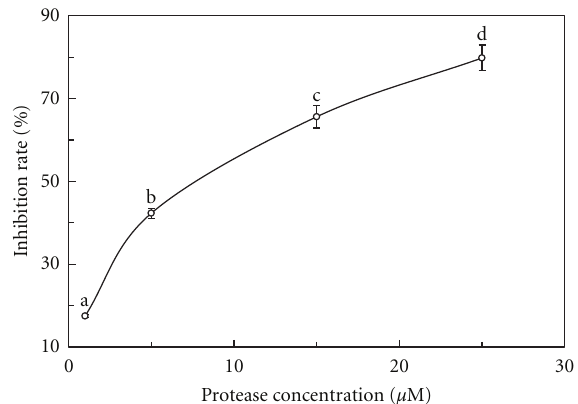
Figure 6: Inhibitory activity of purified protease on HIV-1 RT activity. Results represent mean ± SD ( n = 3). The IC 50 value toward HIV-1 RT was 1 estimated to be 8.3 μ M. Di ff erent letters (a, b, c, etc.) next to the data points indicate statistically significant di ff erence ( P < 0 . 05) when the data are analyzed by analysis of variance followed by Duncan’s multiple range test. Table 3: E ff ects of protease inhibitors on Xylaria hypoxylon protease activity. Protease